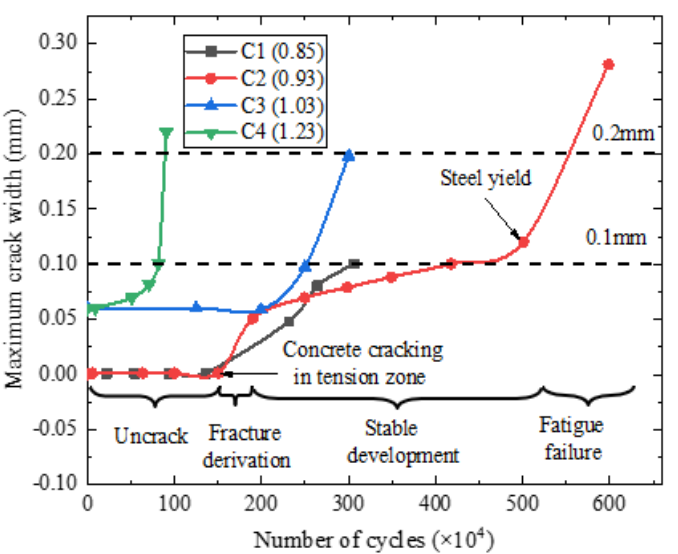
Figure 11. The relationship between the number of cycles and the fatigue main crack width.